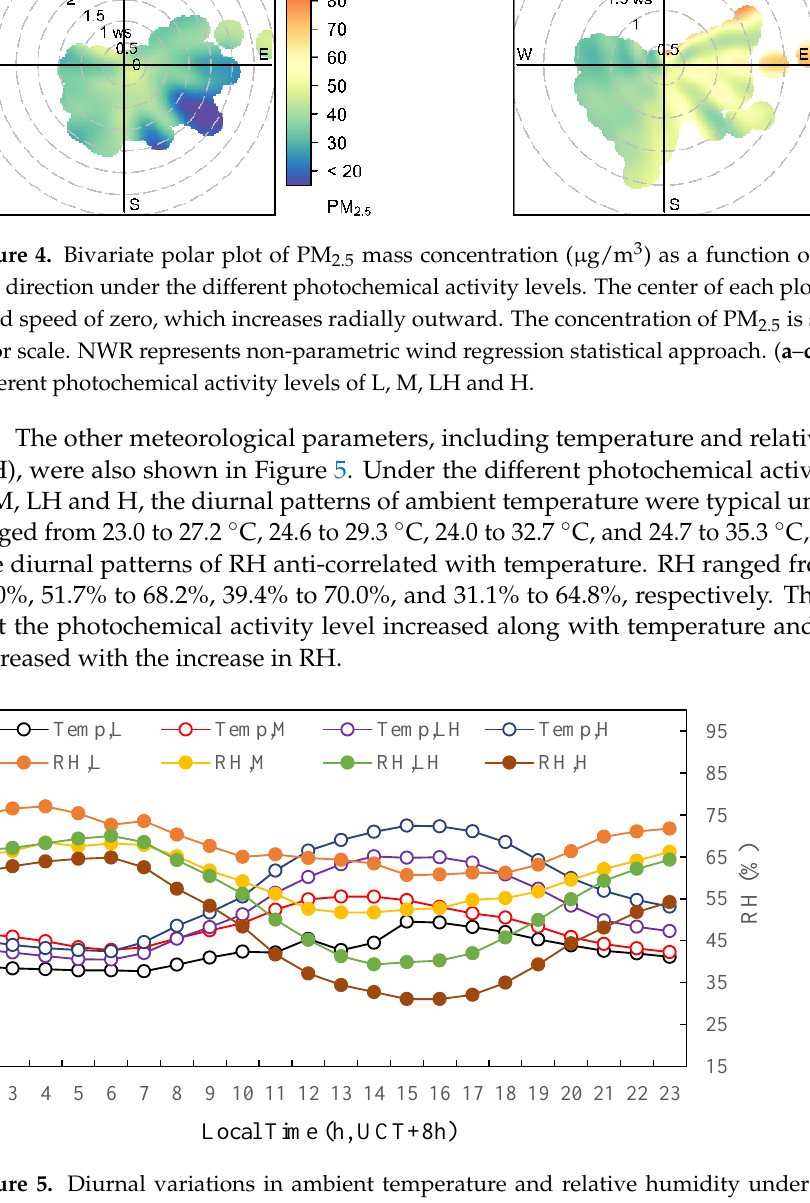
Figure 5. Diurnal variations in ambient temperature and relative humidity under the different pho- tochemical activity levels.